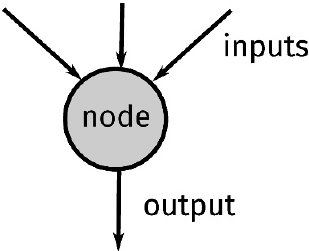
Figure 1 . A node in a data(cid:13)ow graph, where arrows represent lists of values and nodes represent numerical algorithms. In our implementation, a node can take zero or more incoming arrows as input and has exactly one outgoing arrow as